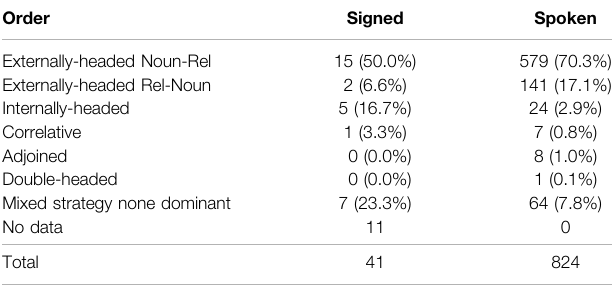
TABLE 8 | Noun/relative clause order in signed and spoken